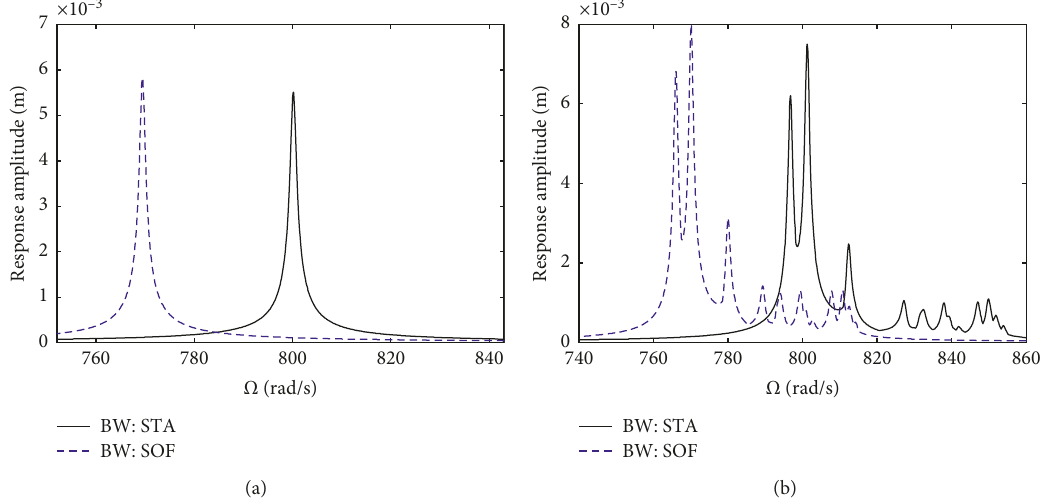
Figure 10: Forced response of tuned and mistuned bladed disk excited by backward traveling wave excitations of 2EO: (a) tuned case and (b) mistuned